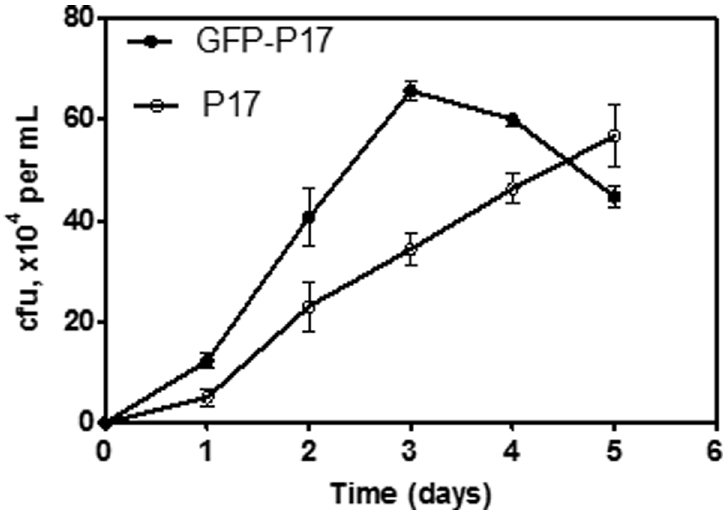
Fig 2. Batch growth curves of GFP-P17 and P17. Growth conditions: 100 µg/L of acetate carbon with supplement of mineral salts. Error bars indicate standard deviation on triplicate samples.